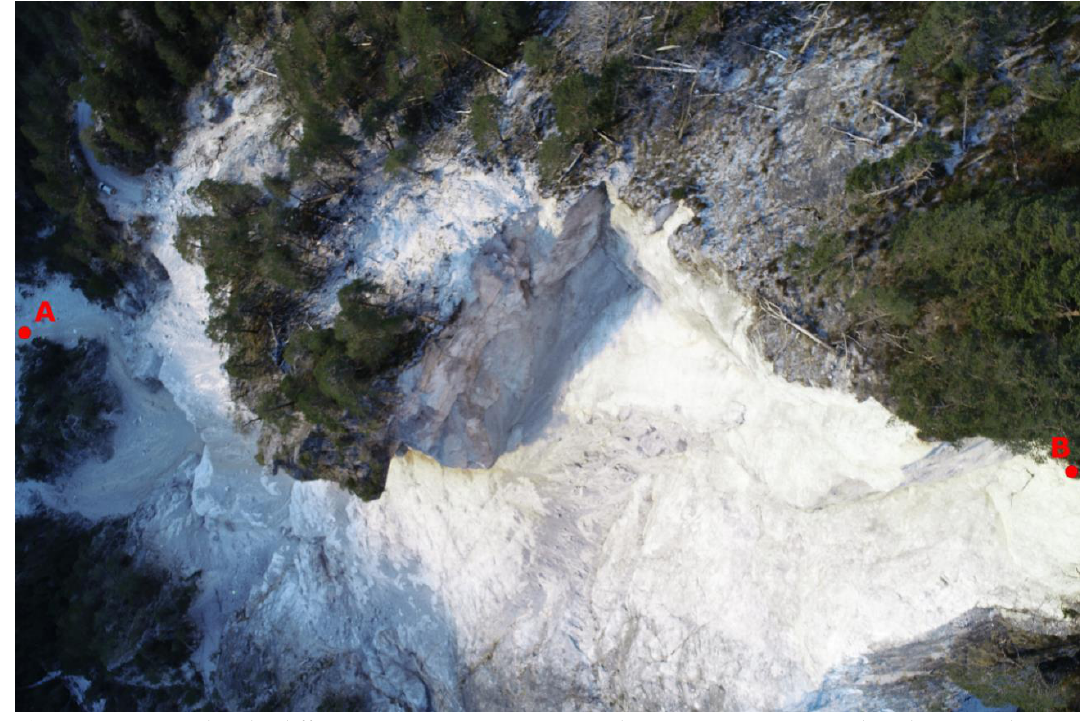
Figure 3 . Extreme height differences in a steep terrain result in a varying GSD within the vertical Figure 3. Extreme height di ff erences in a steep terrain result in a varying GSD within the vertical image image (~0.5 cm in point A and ~7.9 cm in point B). (~0.5 cm in point A and ~7.9 cm in point